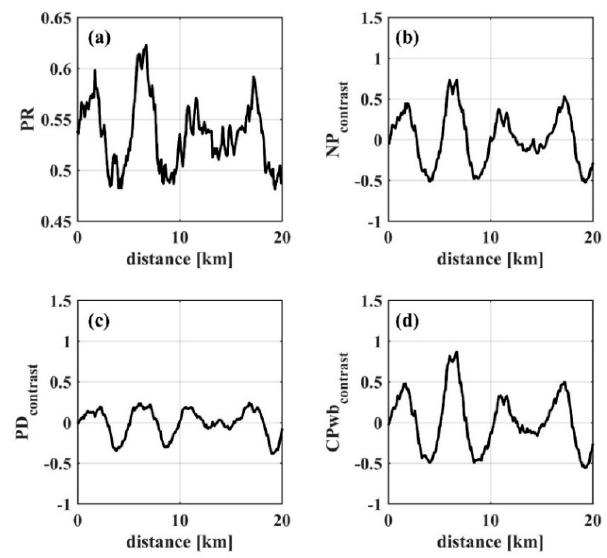
Figure 2. Transects across the atmospheric gravity waves along the red arrow shown in Figure 1a: ( a ) PR, ( b ) NP contrast, ( c ) PD contrast, ( d ) CPwb contrast.